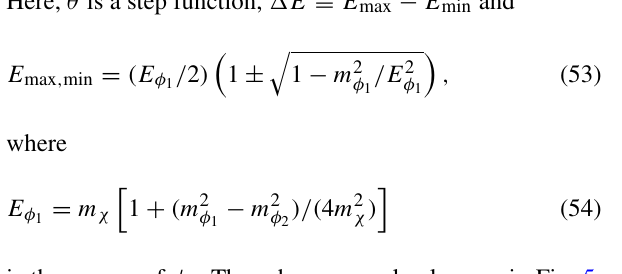
Here, θ is a step function, (cid:15) E ≡ E max − E min